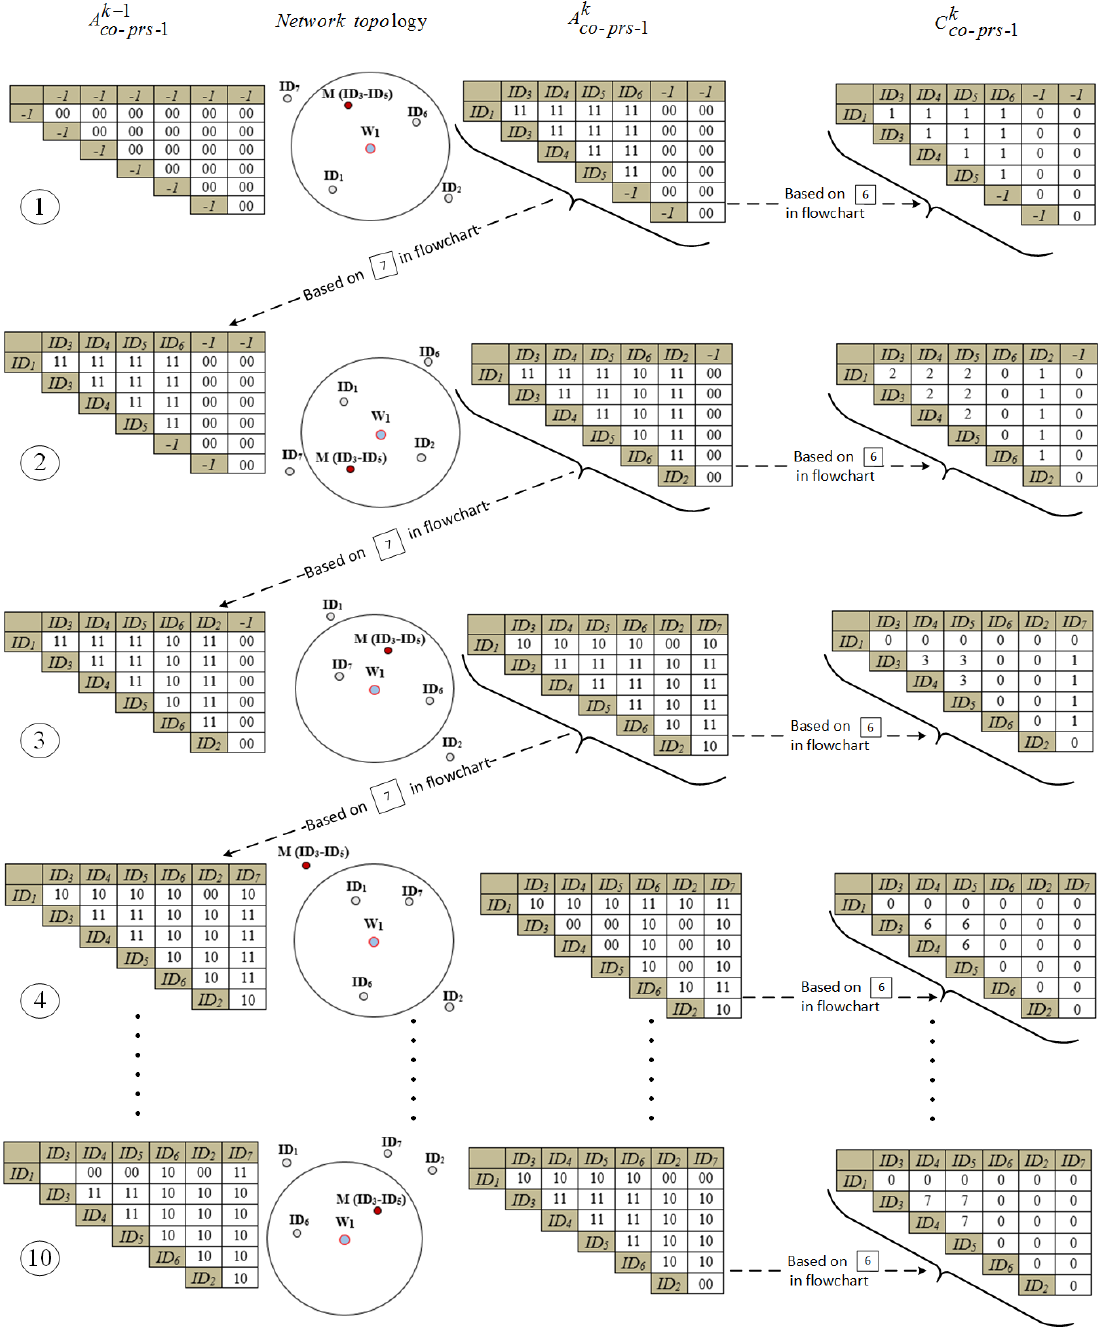
Figure 5. A pictorial representation of the advancement of the information collection phase in a typical watchdog, herein, W 1